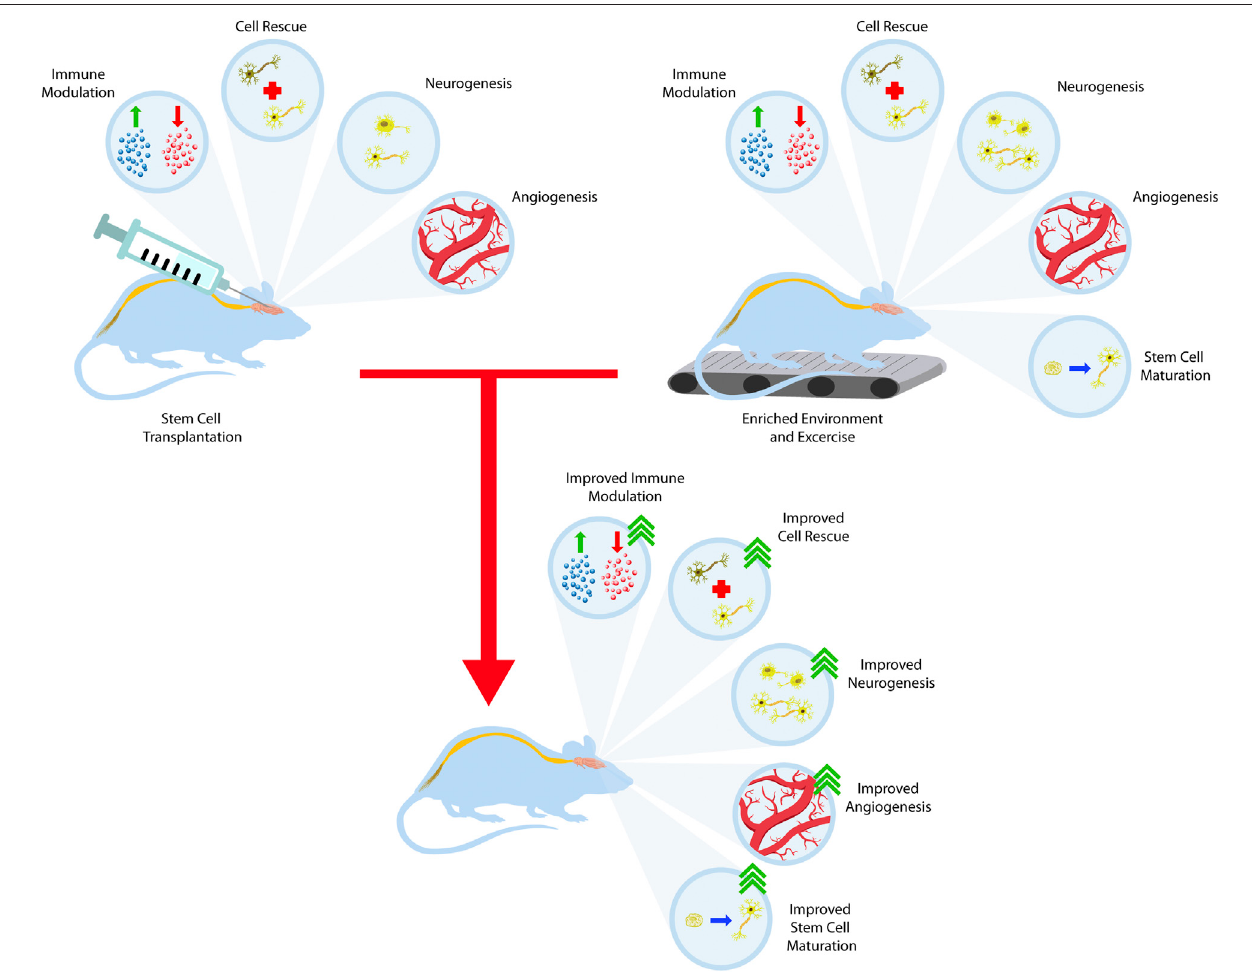
FIGURE 3 | Training the stem cell graft to integrate with the host brain. Stem cell transplantation offers many therapeutic bene fi ts such as immune system modulation, dying cell rescue, neurogenesis, and angiogenesis. When combined with the bene fi ts of EE and exercise, these outcomes synergize and lead to better